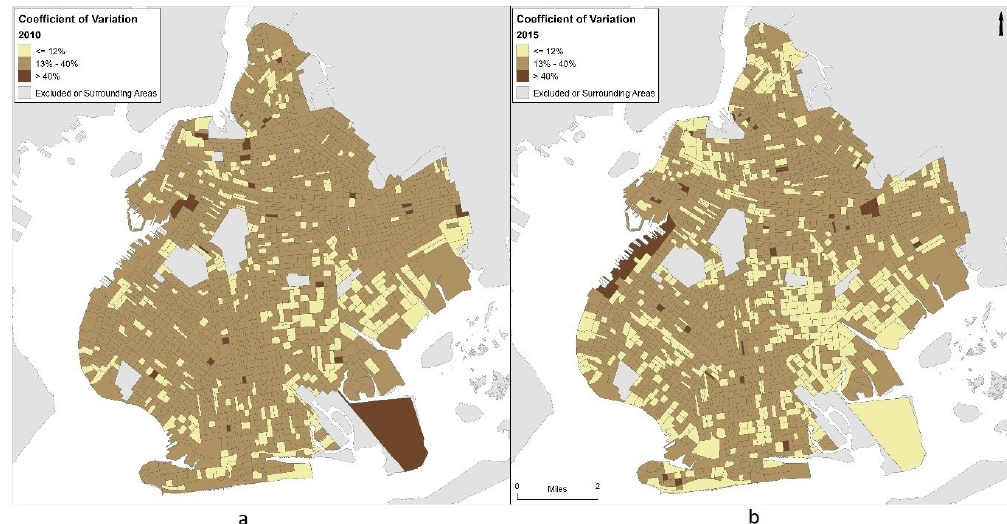
Figure 5. Coefficient of variation for American Community Survey five-year estimates of per capita income in 2010 ( a ) and 2015 ( b ).